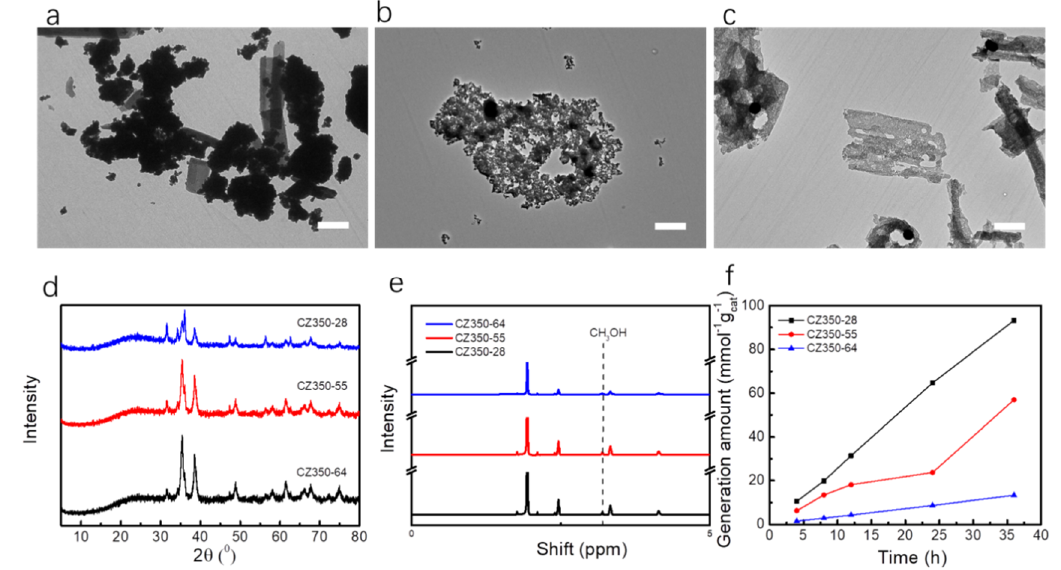
Figure 4. TEM images of the products synthesized with different zinc contents, 40.2 wt% ( a ), 51.3 wt% ( b ) and 58.7 wt% ( c ), corresponding XRD patterns ( d ) 1H NMR spectra ( e ) and the production of methanol varies over time ( f ). Scale bar: 800 nm.